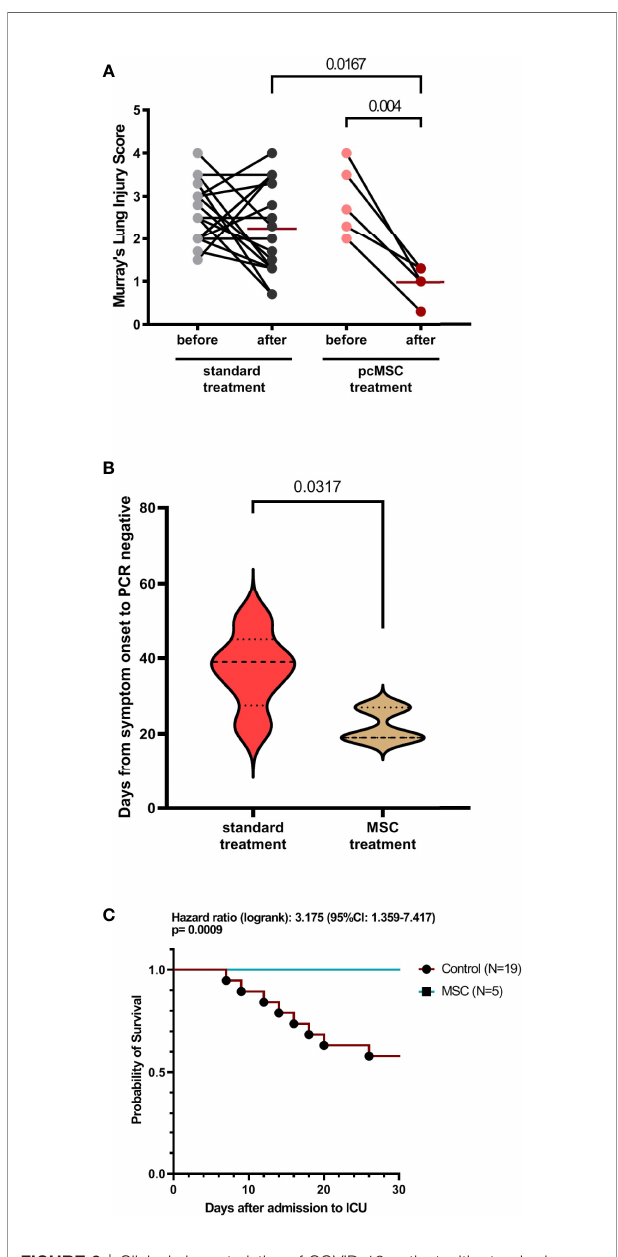
FIGURE 2 | Clinical characteristics of COVID-19 patient with standard or MSC treatment. (A) Murray ’ s lung injury score of standard treatment and MSC treatment group was shown as before and after treatment; timing of after was adjusted as one week after recruitment. (B) Duration of viral clearance by detecting viral COVID molecular testing by PCR in control and MSC treated group. (C) Survival analysis of control and MSC treated